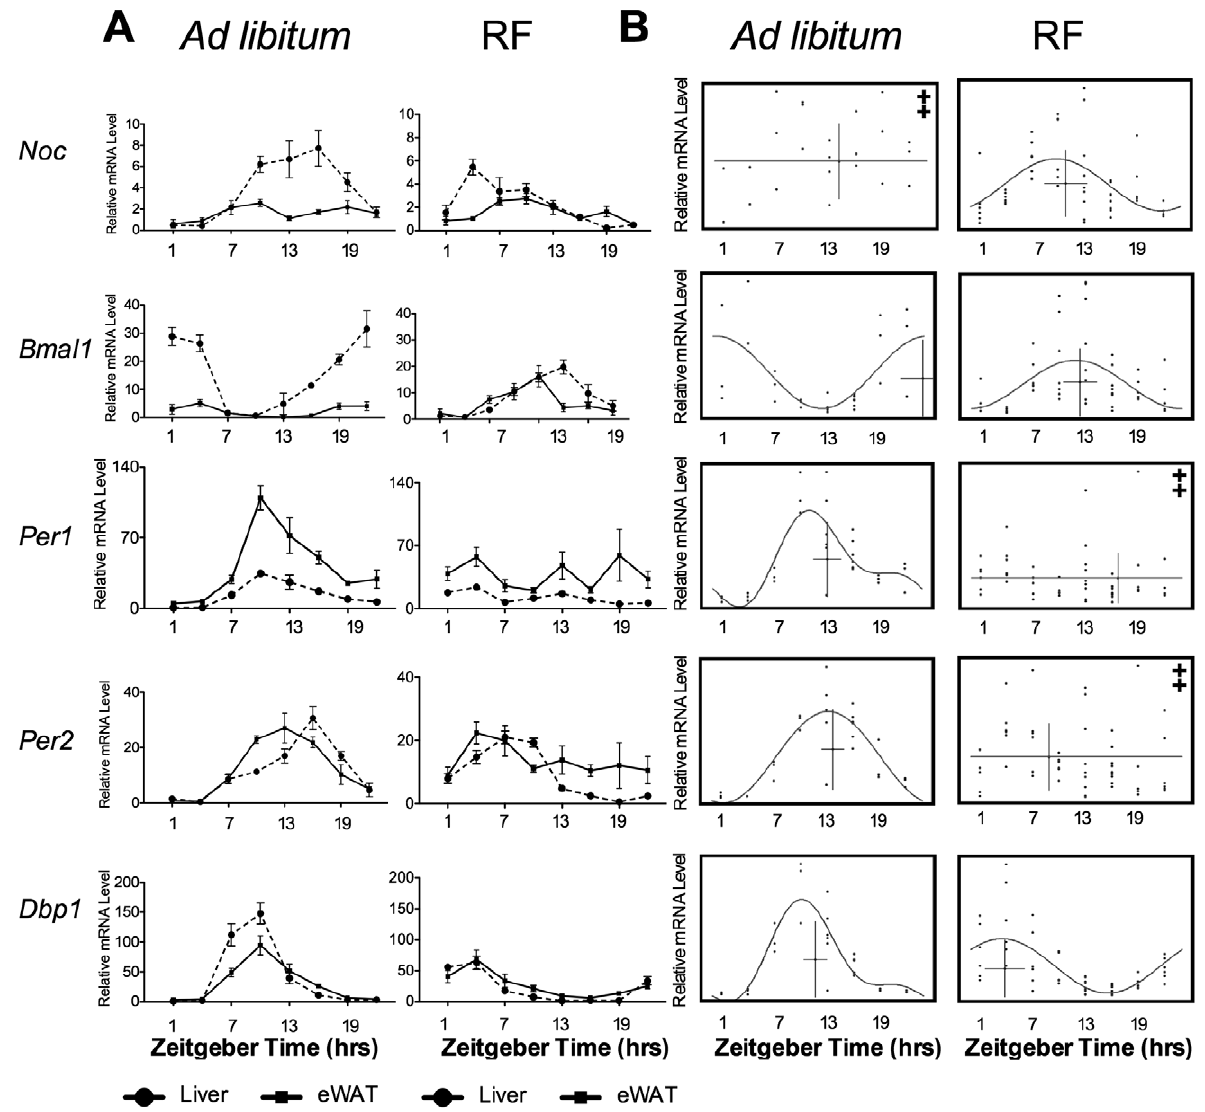
Figure 3. Restricted feeding results in the rhythmic expression of Nocturnin in the epididymal white adipose tissue. ( A ) Gene expression analysis conducted on the liver (dashed line) and on the eWAT tissue (solid line) in ad libitum fed mice (left panel) and restricted fed mice (RF, right panel). Data represent the mean ( 6 SEM) of a group for each time point (n=3–6 per timepoint for the ad libitum condition, and n=5–9 for the restricted fed condition). Ad libitum expression profiles of Nocturnin shown in 3A are the same data as shown in Figure 1A, and is regraphed here for convenient comparison. ( B ) CircWave analysis of eWAT gene expression data from (A) from ad libitum (left panel) and restricted fed mice (RF, right panel). The graphs are as described in Figure 1A. For all gene expression values, except those graphs marked with { , p-values , 0.002. { marks the data for which no curve could be fit. Note that the Nocturnin ad libitum data from liver and eWAT in this figure are the same data as shown in Figure 1A and are shown again here for direct comparison. triglyceride-storing lipid droplets [24,25,26,27]. It has been shown activation (Figure 5D). We next examined whether Nocturnin could in Xenopus laevis that Nocturnin rhythmicity is regulated by p-CREB, be induced by a rise in cAMP levels in mature 3T3-L1 adipocytes. but the activation of Nocturnin by p-CREB has not been Treatment of these cells with forskolin also resulted in an acute demonstrated in mice [28]. There are conserved putative CREs induction of Nocturnin expression (Figure 5E) showing that Nocturnin within the 500 bp region upstream of Nocturnin’s first exon is regulated by the signaling cascade which occurs during lipolysis (Figure 5A), and Nocturnin is acutely induced by 3-isobutyl-1- in white adipose tissue. methylxanthine (IBMX) and forskolin in NIH3T3 fibroblasts (Figure 5B,C). Overexpression of PKA in NIH-3T3 fibroblasts resulted in an increase of Nocturnin expression, whereas cells co- transfected with PKA and a dominant negative CREB construct failed to exhibit the increase in Nocturnin expression, demonstrating genes in the liver suggesting that Nocturnin is an output of the that mammalian Nocturnin mRNA expression is induced by CREB